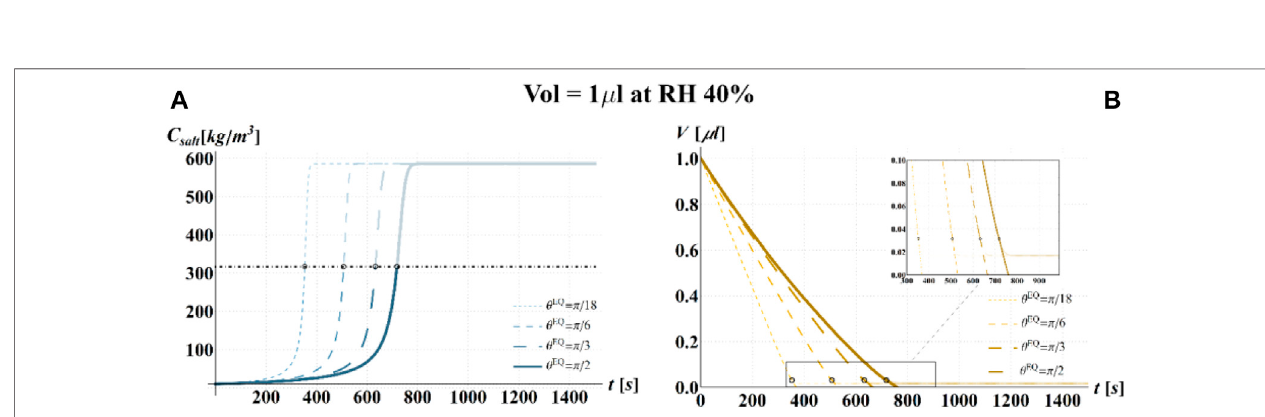
FIGURE8| Resultsofmodelsimulationsoftheevaporationprocessofasessiledropofaqueoussolutionwithastartingvolumeof1 μ L,atanRH (cid:2) 80%,intermsof time evolution of (A) the salt concentration, C salt , and (B) the volume, V, for fl at surfaces with different wettability, at T (cid:2) 25 ° C.